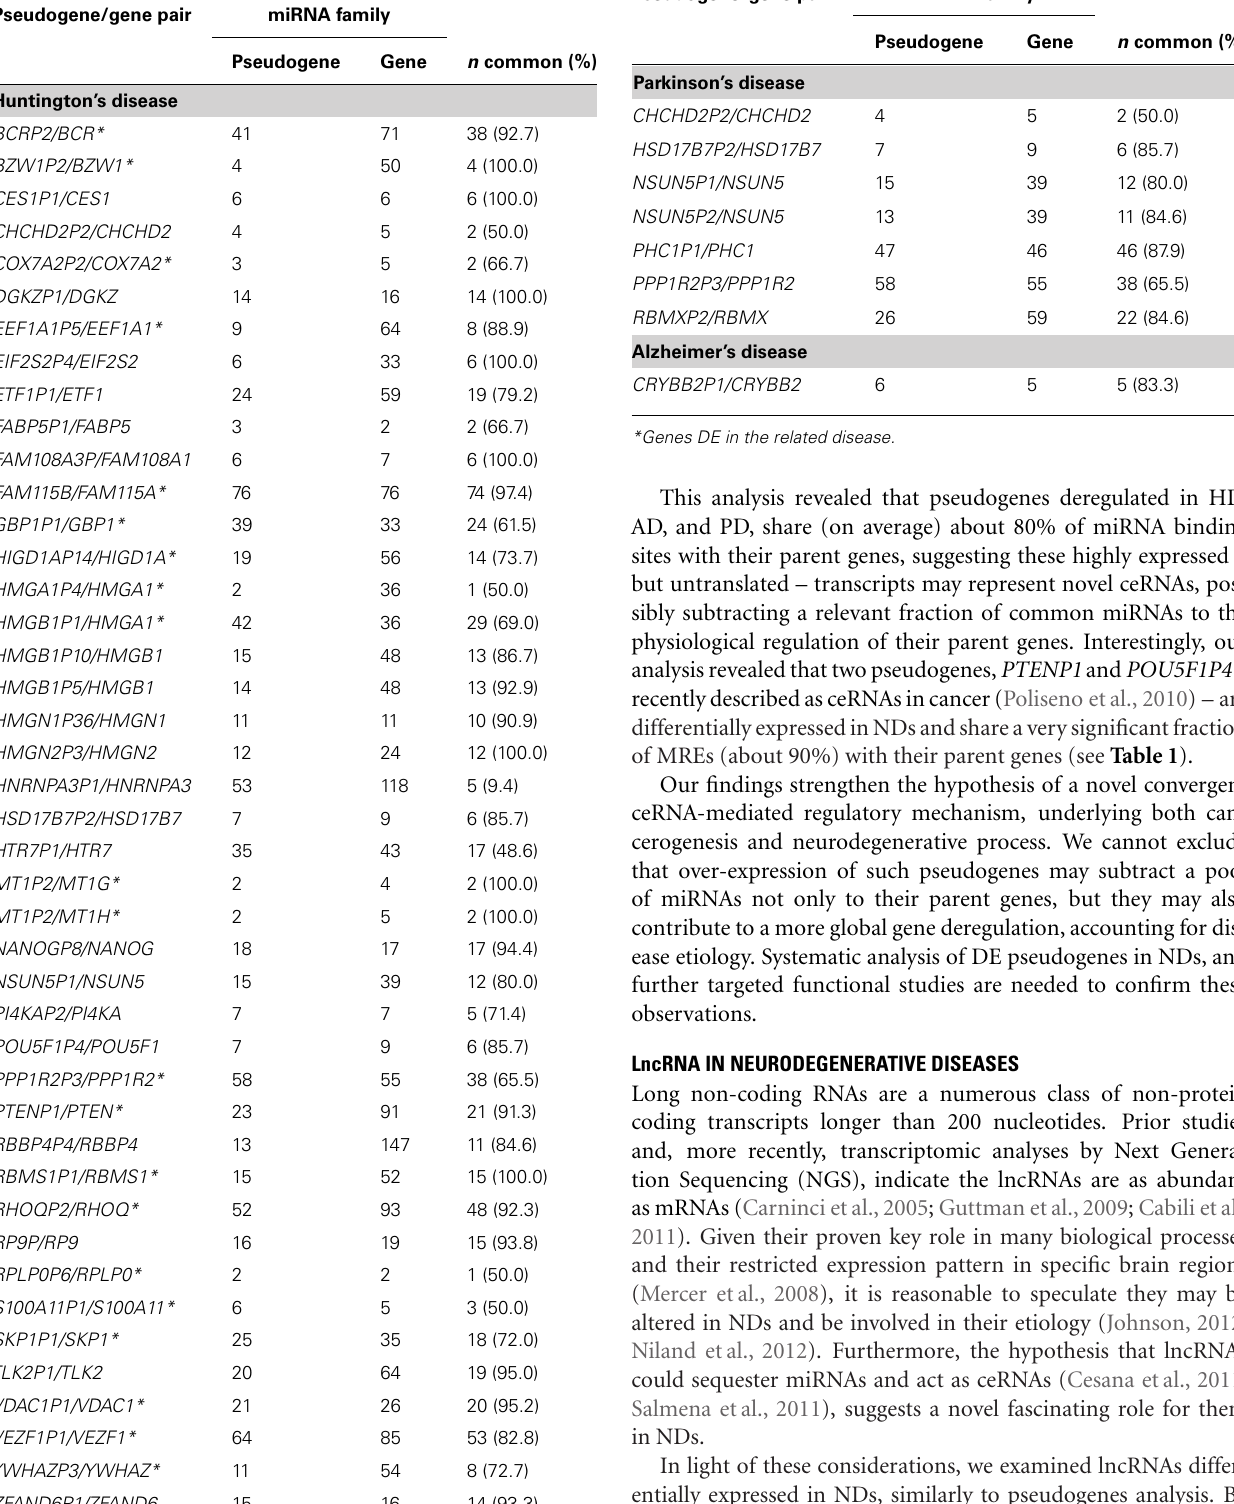
Table 1 | Pseudogenes deregulated in HD, PD andAD sharing common miRNA binding sites with their parent genes. Pseudogene/gene